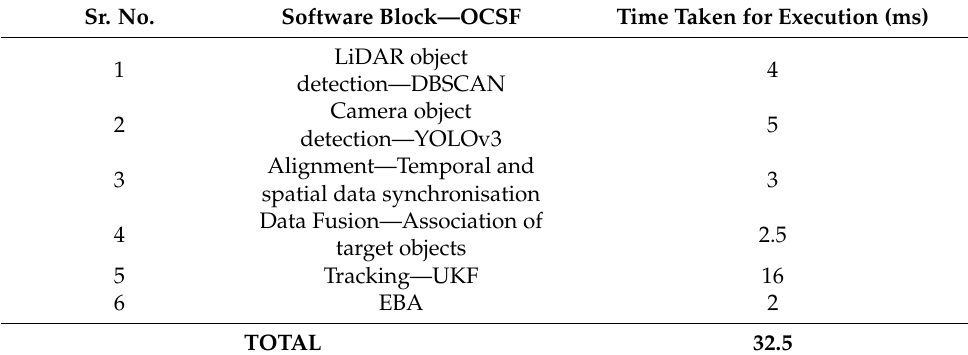
Table 6. Time profiling for EBA driven with